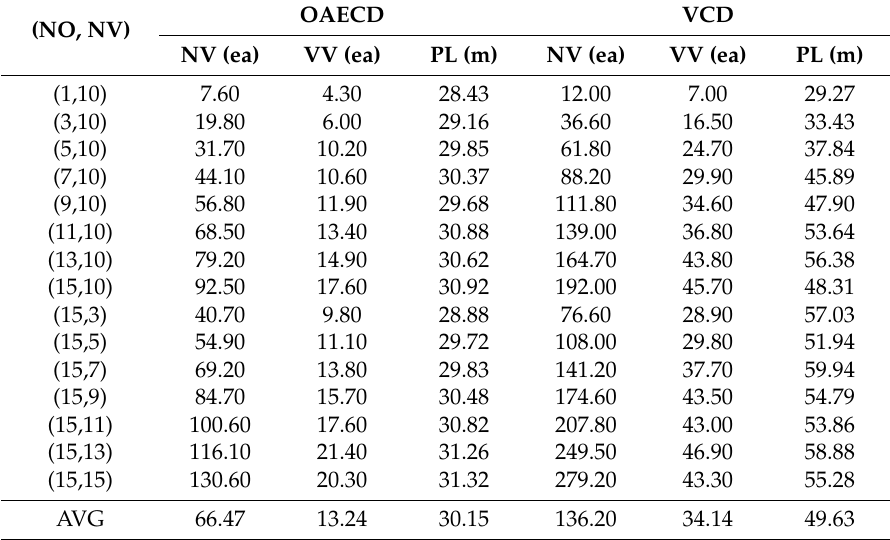
Table 3. Performance comparison between modified Opposite Angle-Based Exact Cell Decomposition (OAECD) and Vertical Cell Decomposition (VCD) (The numbers of obstacles and vertices of each obstacle were fixed as 15).